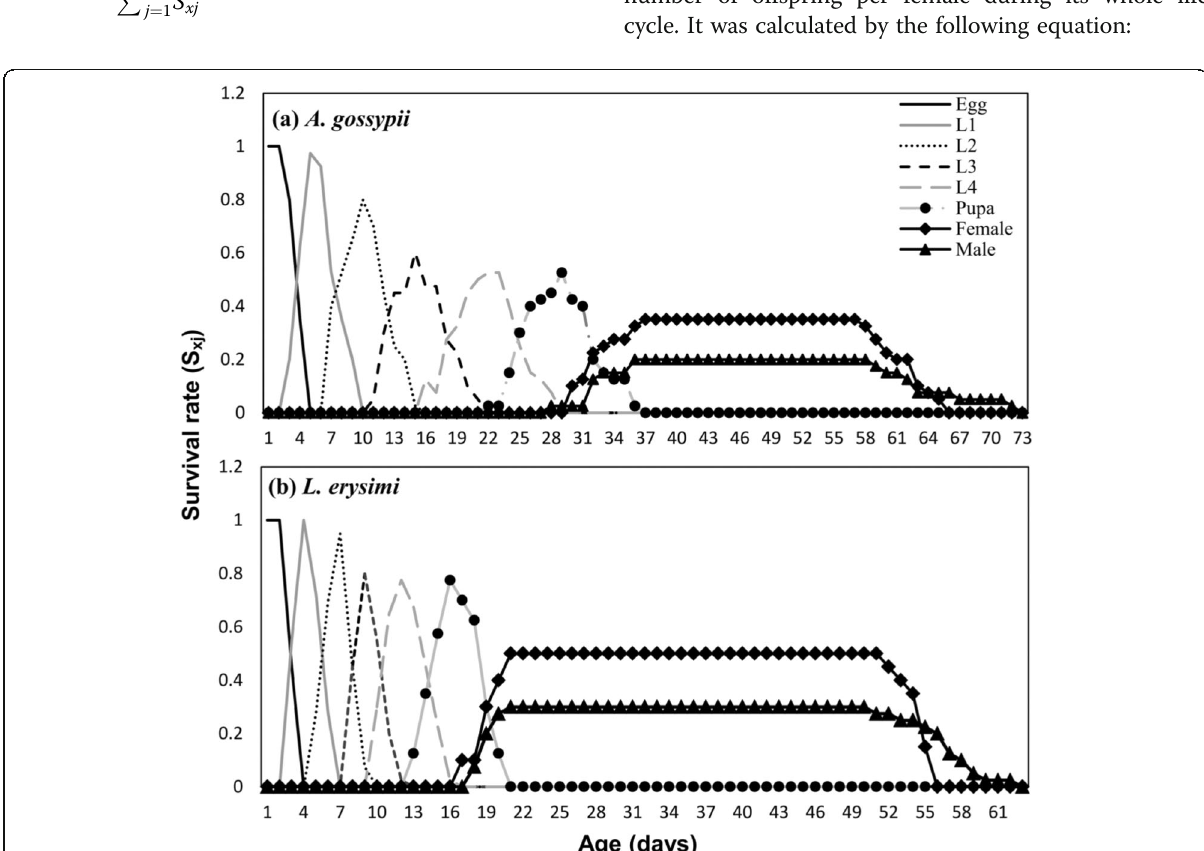
Fig. 1 Age-stage-specific survival rate ( S xj ) of Hippodamia convergens fed on two aphid species